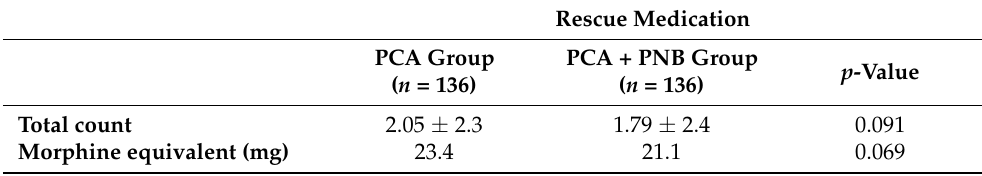
Table 3. Comparison of rescue pain medication between the PCA and PCA + PNB groups after total hip arthroplasty.